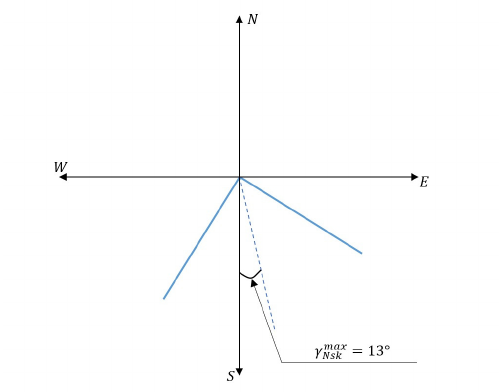
Figure 7. Novosibirsk detector optimal orientation.